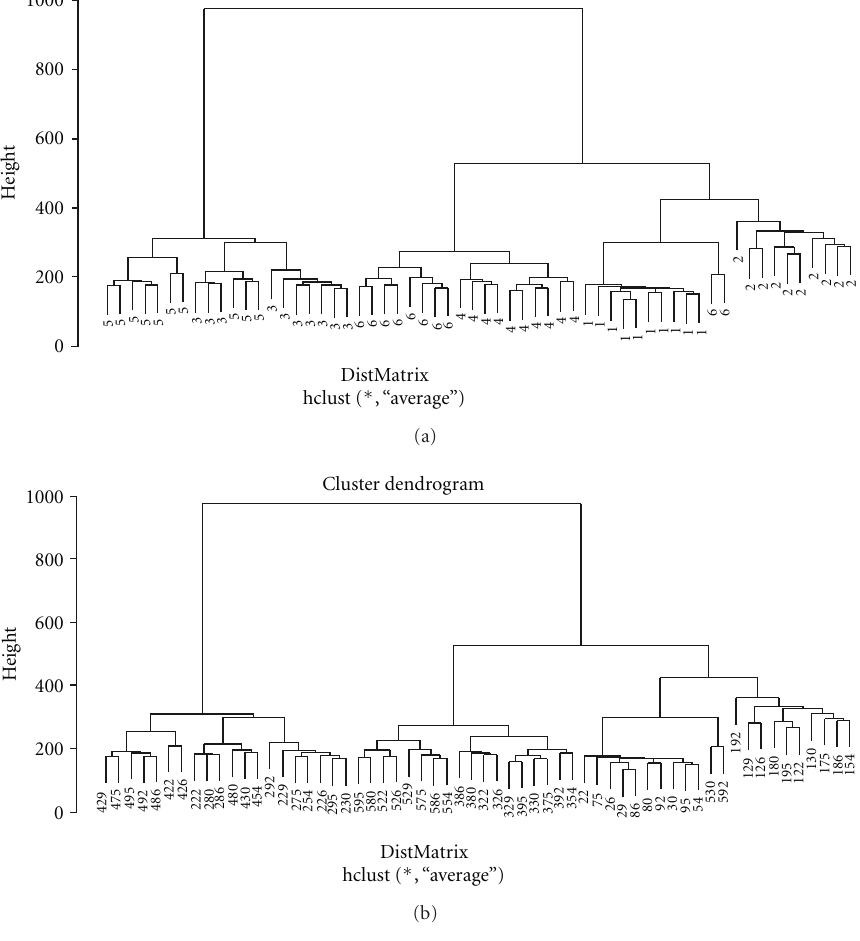
Figure 6: (a) Six characteristic groups at the dendrogram by using DTW similarity function. (b) The corresponding row numbers of the dataset at the dendrogram by using DTW similarity